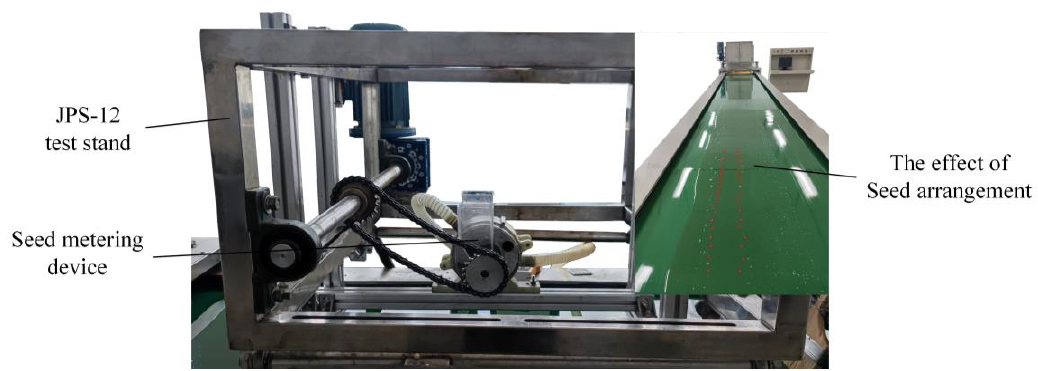
Figure 11. Seed arrangement performance test stand.